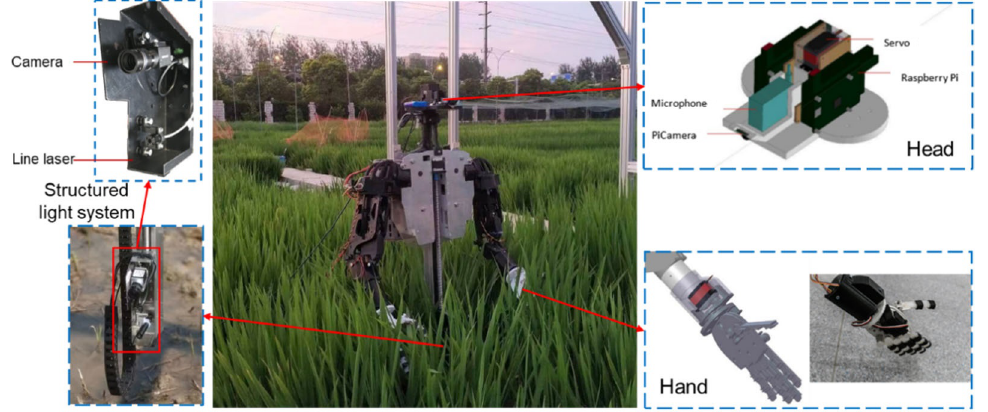
Figure 1. Interactively cognitive humanoid phenotyping robot.